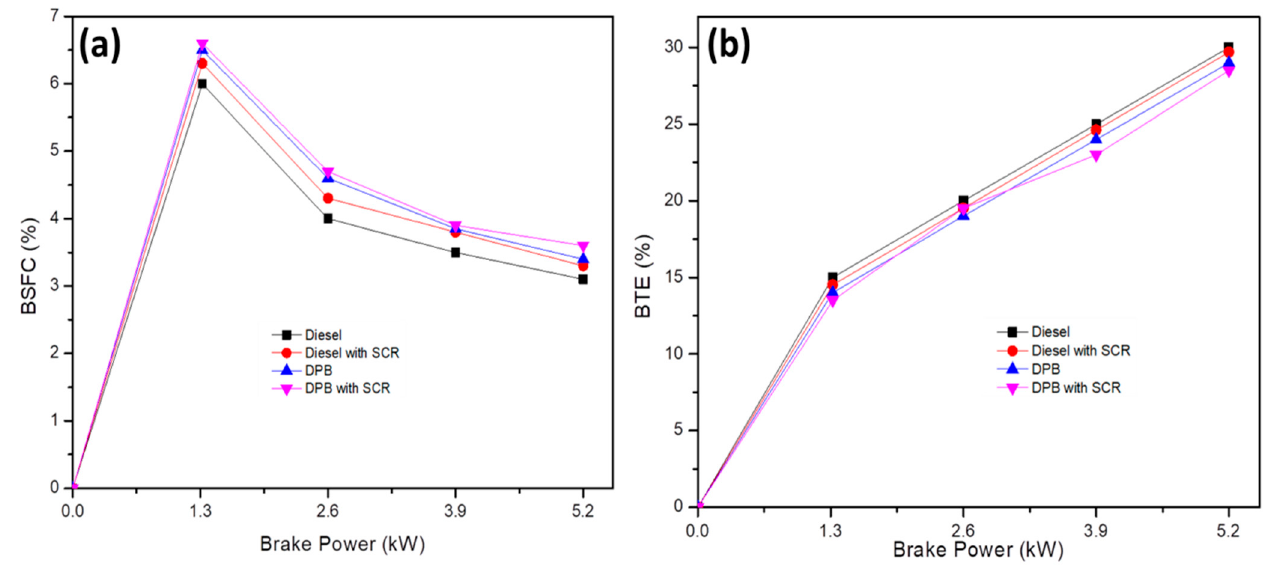
Figure 6. Variation of BSFC ( a ) and BTE ( b ) corresponding with engine load. BSFC, brake fuel consumption; BTE, brake thermal efficiency.